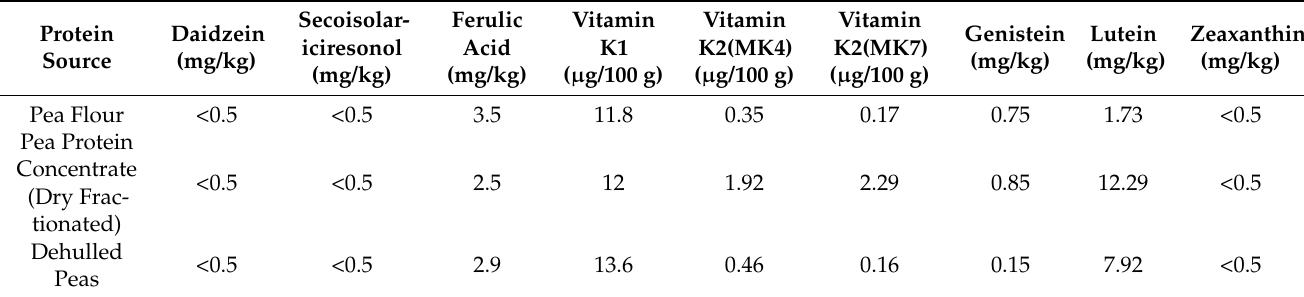
Table 2. Phytonutrient content in whole pea, pea flour and pea protein